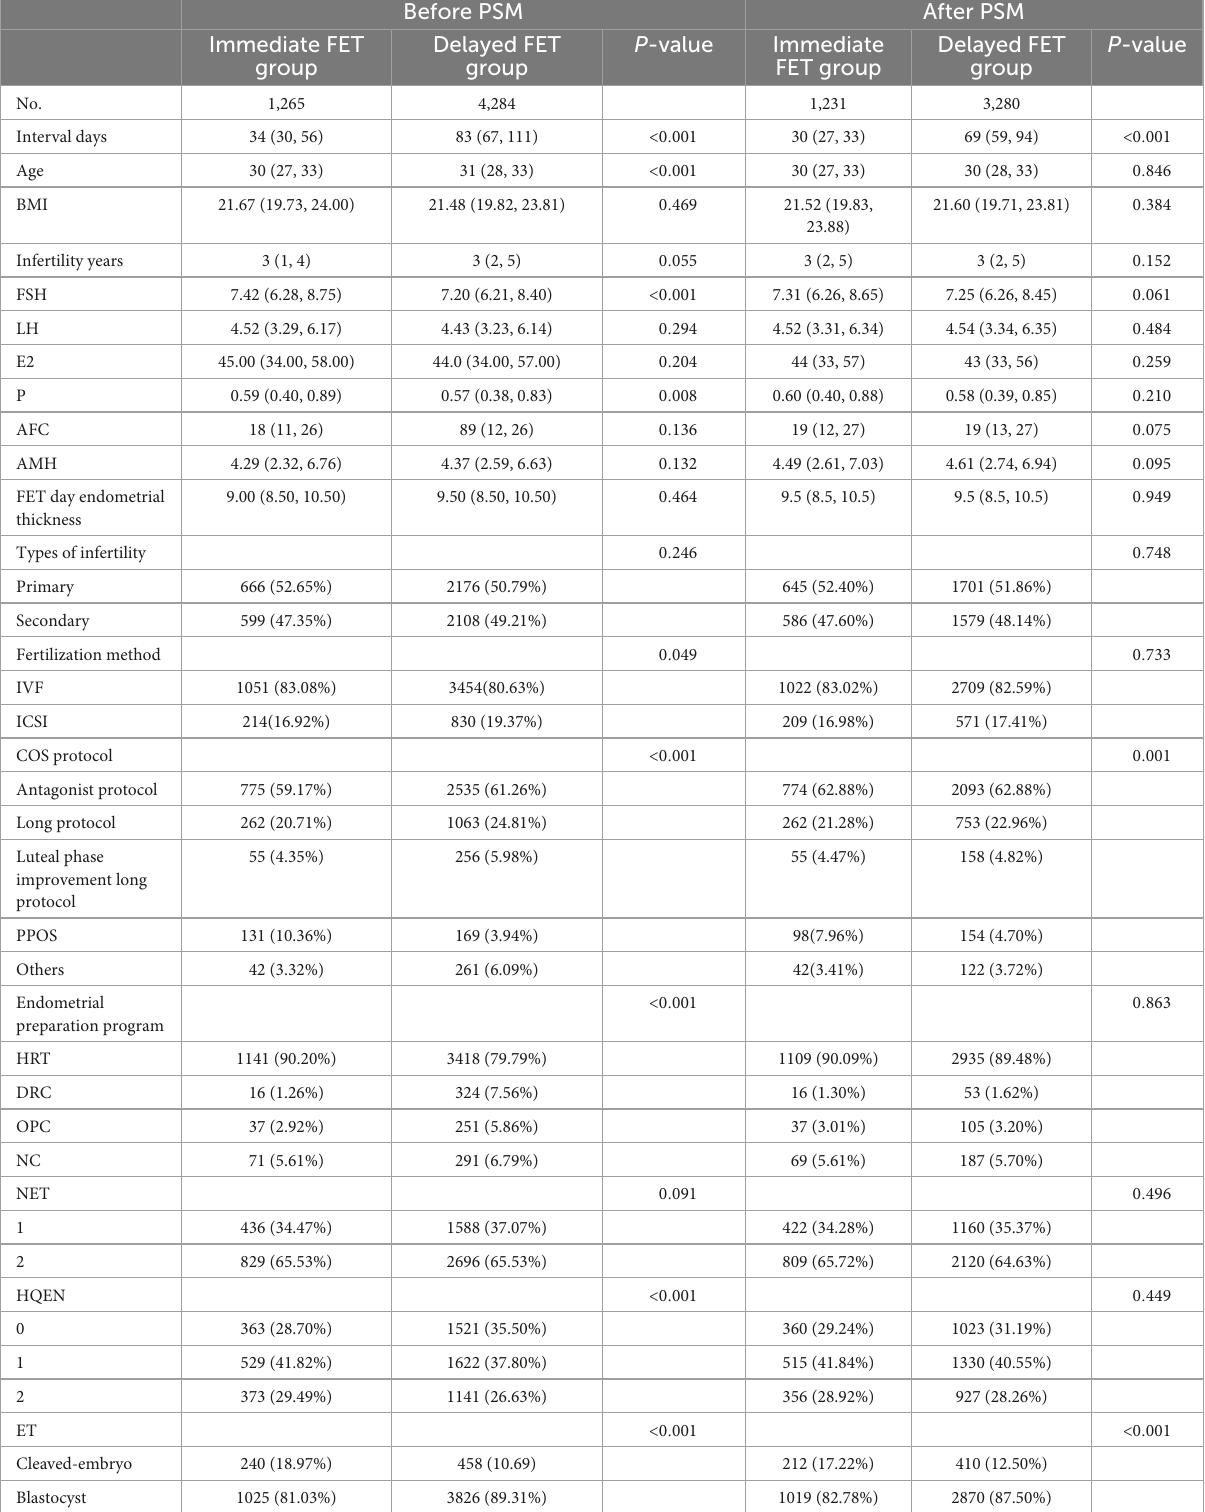
TABLE 1 Comparison of baseline data between the groups before and after propensity